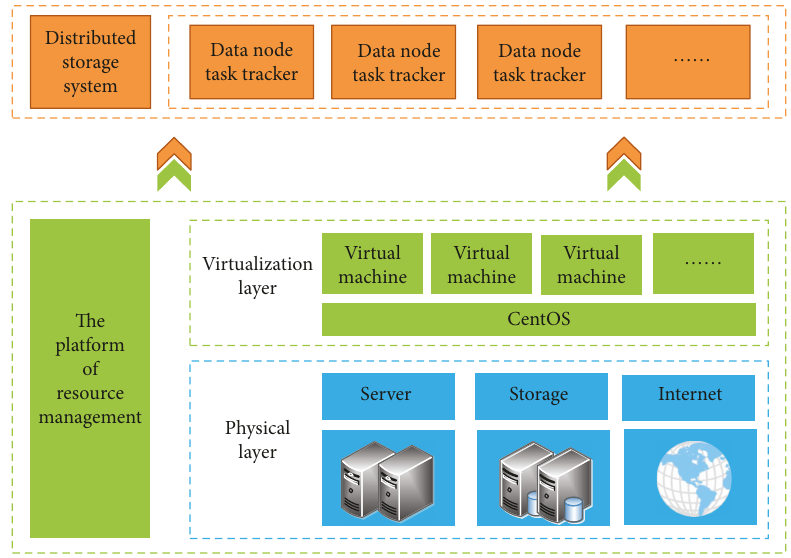
Figure 13: Big data platform for iron and steel enterprises bases on Table 2: Satty scoring system of 9 grades.